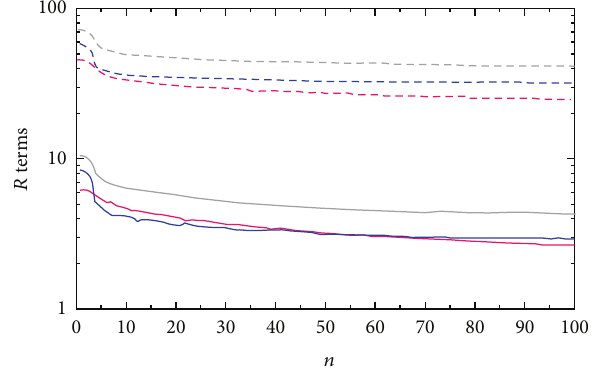
Figure 10: 𝑅 -30s, 𝑅 𝜂 -30s, and 𝑅 -30 s for the retrieval in vr Figure 4(a) plotted by the gray, red, and blue solid curves, respec- tively, as functions of iteration number 𝑛 . 𝑅 -5min, 𝑅 𝜂 -5min, and 𝑅 -5min for the retrieval in Figure 8(a) plotted by the gray, red, and vr blue dashed curves, respectively, as functions of 𝑛 .